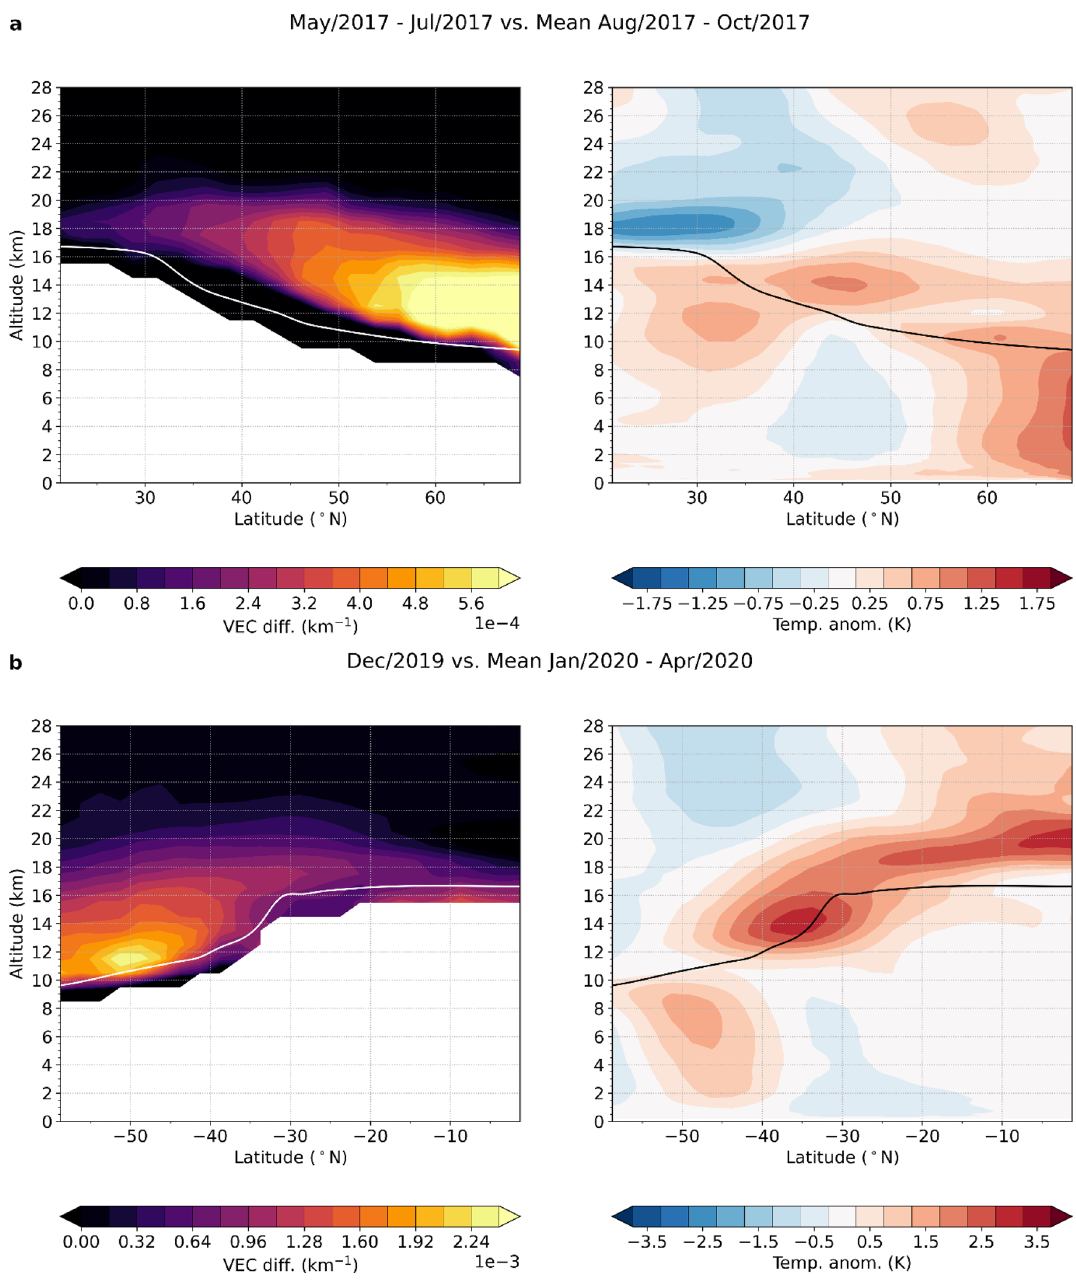
Figure 6. Wildfire induced short-term climate signals. ( a ) Difference in mean aerosol concentration (VEC; left panel) four months before the 2017 North American wildfires vs. three months after the event and the corresponding impact on RO temperature anomalies (right panel). ( b ) Same as ( a ), but for the Australian wildfire in 2019/20. To avoid influence of the southern hemispheric SSW event in 2019, only December 2019 before the event was used for the difference calculation. Note the different ranges for VEC and temperature in ( a ) and ( b